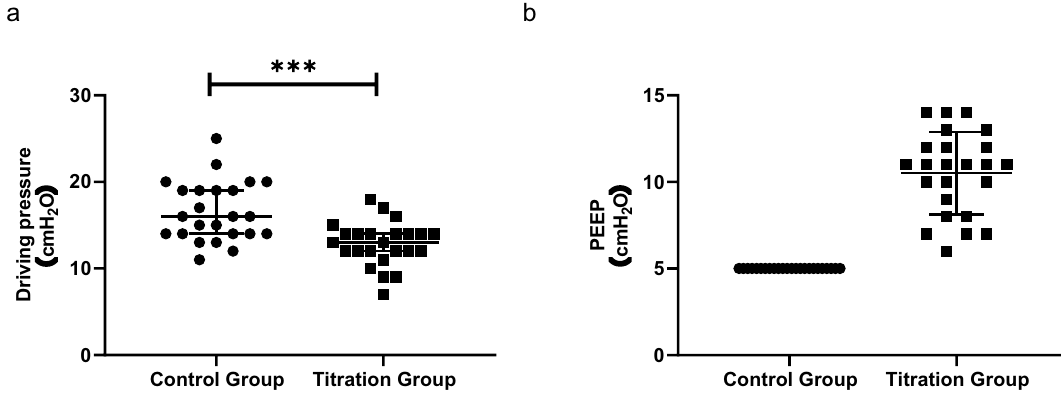
Figure 2. Distribution plot for driving pressure ( a ) and PEEP level ( b ). Lines indicate median with IQR. PEEP positive end-expiratory pressure. *** p < 0.001.